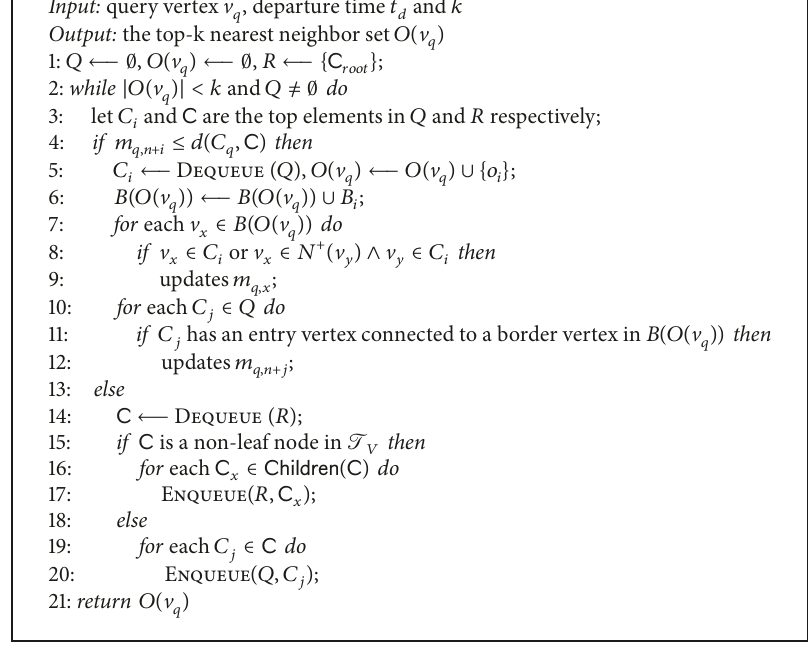
Algorithm 4: 𝑘 NN-Query ( V 𝑞 , 𝑡 𝑑 , 𝑘